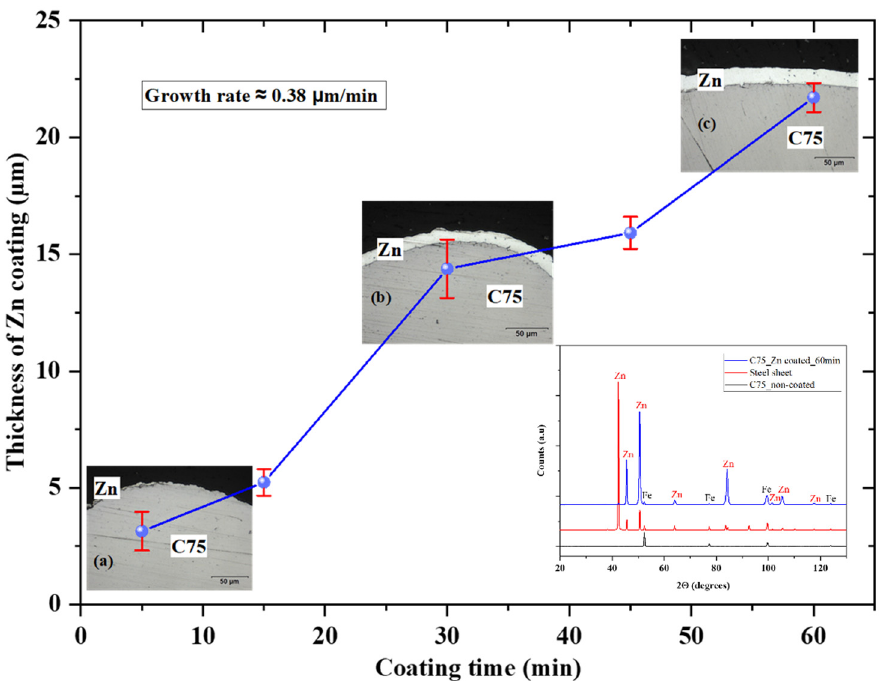
Figure 8. Thickness variation and light microscopy images of ( a ) 5 min, ( b ) 30 min, and ( c ) 60 min coated Zn layer on C75 TWS. Inset: XRD diffractogram of Zn coated C75 compared with the diffrac- tograms of non-coated C75 and galvanized steel sheet.